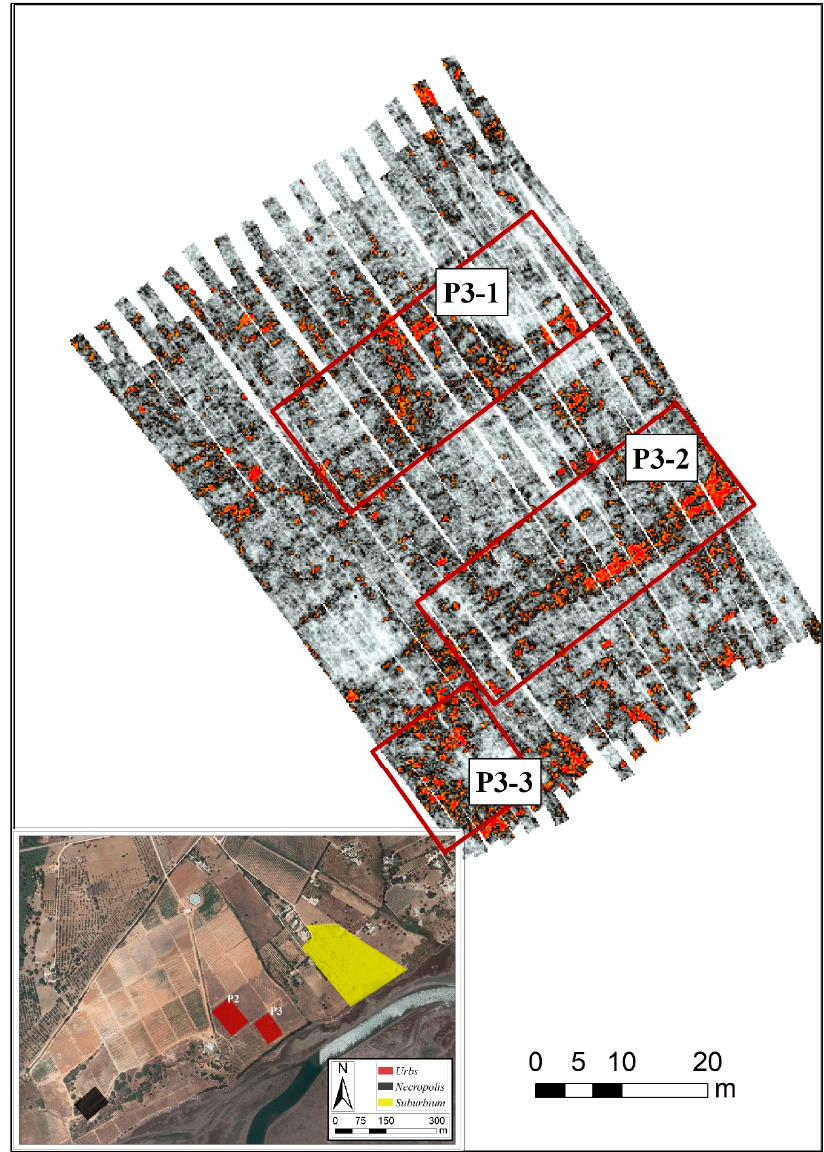
Figure 7. Groups of alterations in project